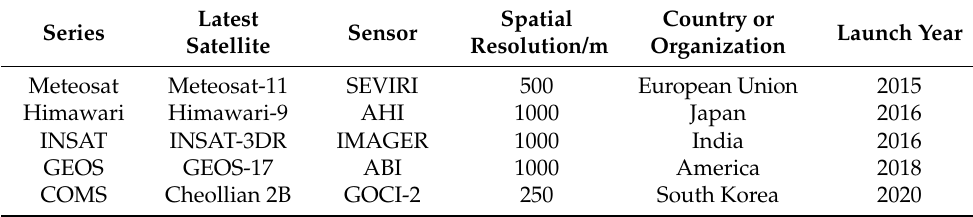
Table 1. Information of the latest geosynchronous satellites.